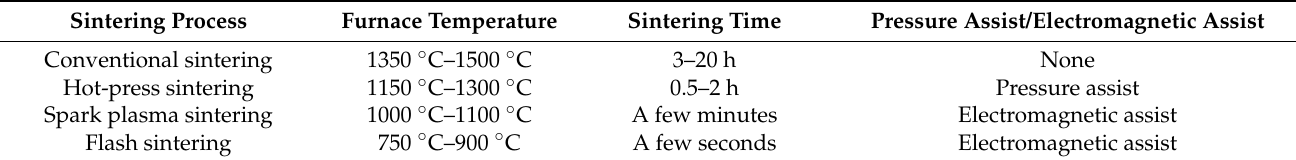
Table 1. The comparison of sintering